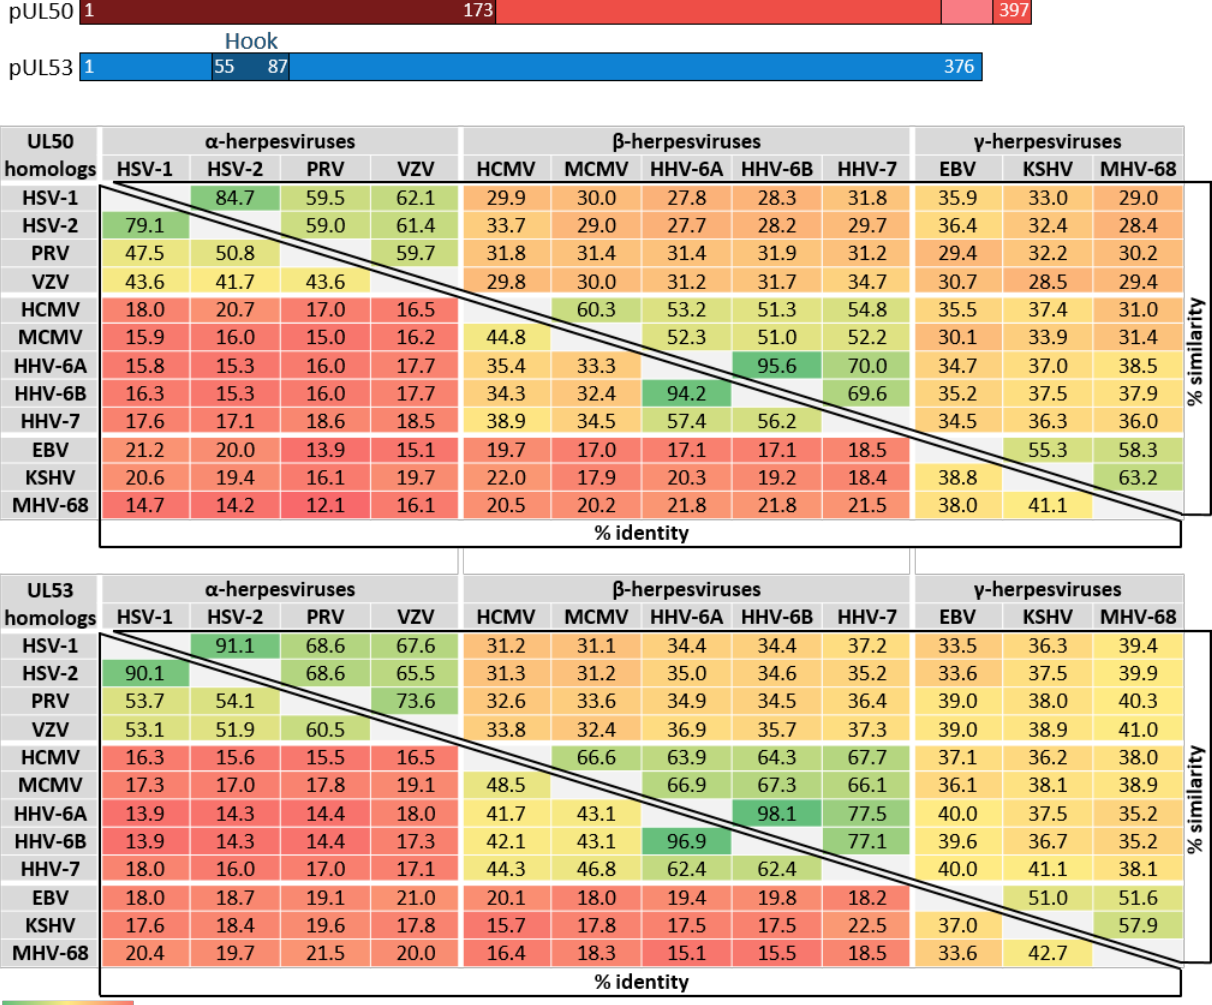
Figure 3. Amino acid sequence identities and similarities in % of pUL50 and pUL53 homologs of nine human and three animal herpesviruses. ( A ) Schematic depiction of pUL50 and pUL53. Amino acid positions are represented by numbers; TMD, transmembrane domain. ( B ) Homologs of HCMV pUL50 (groove proteins). ( C ) Homologs of HCMV pUL53 (hook proteins). UniProt accession numbers: HSV-1, P10218 and P10215; HSV-2, P89457 and P89454; VZV, P09280 and P09283; PRV (SuHV-1), T2FKZ7 and G3G955; HCMV, P16791 and P16794; MCMV (MuHV-1), D3XDN8 and D3XDP1;